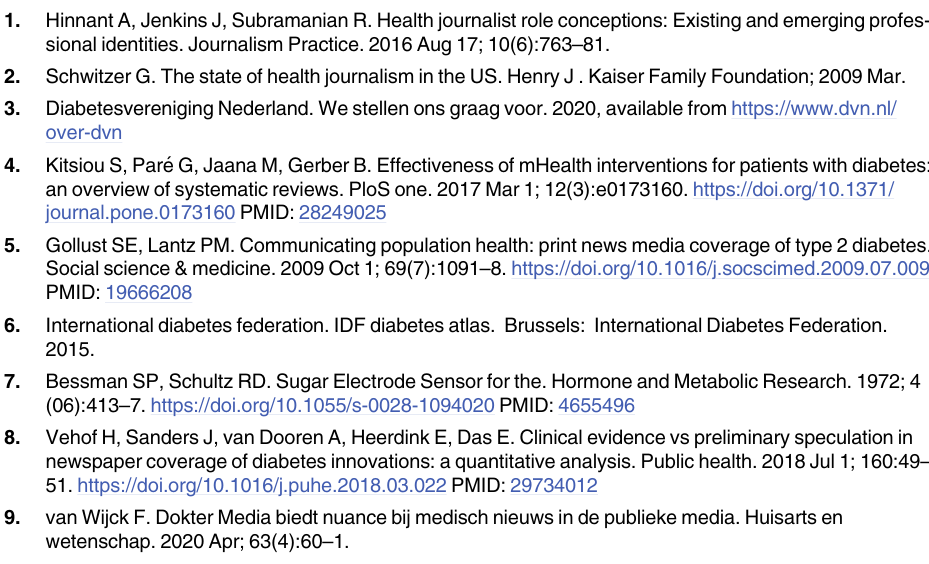
S1 Table. List with the names of the 14 participating Facebook